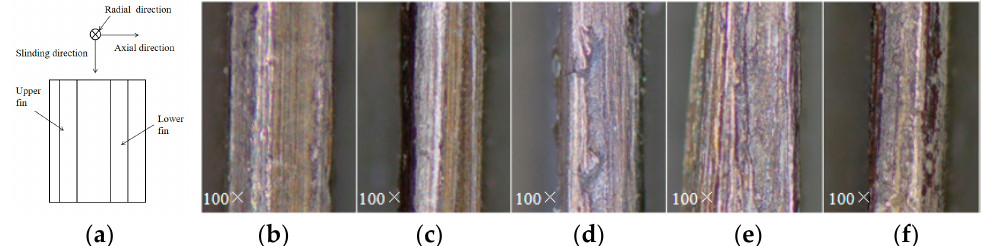
Figure 10. Wear morphology of labyrinth seal fin after rubbing. ( a ) Schematic diagram of fin tip shooting position and direction. ( b ) ra ( c ) ax ( d ) ra-ax ( e ) ax-ra ( f )